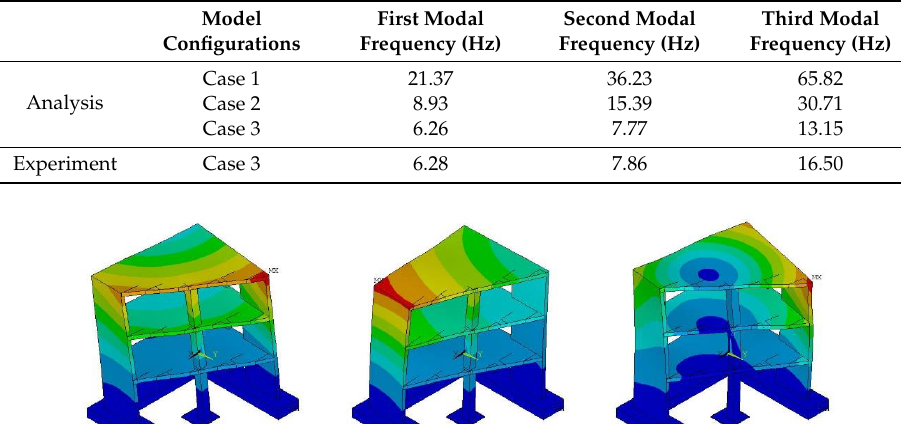
Table 5. Natural frequencies of the SMART 2013 RC structure for three model cases.